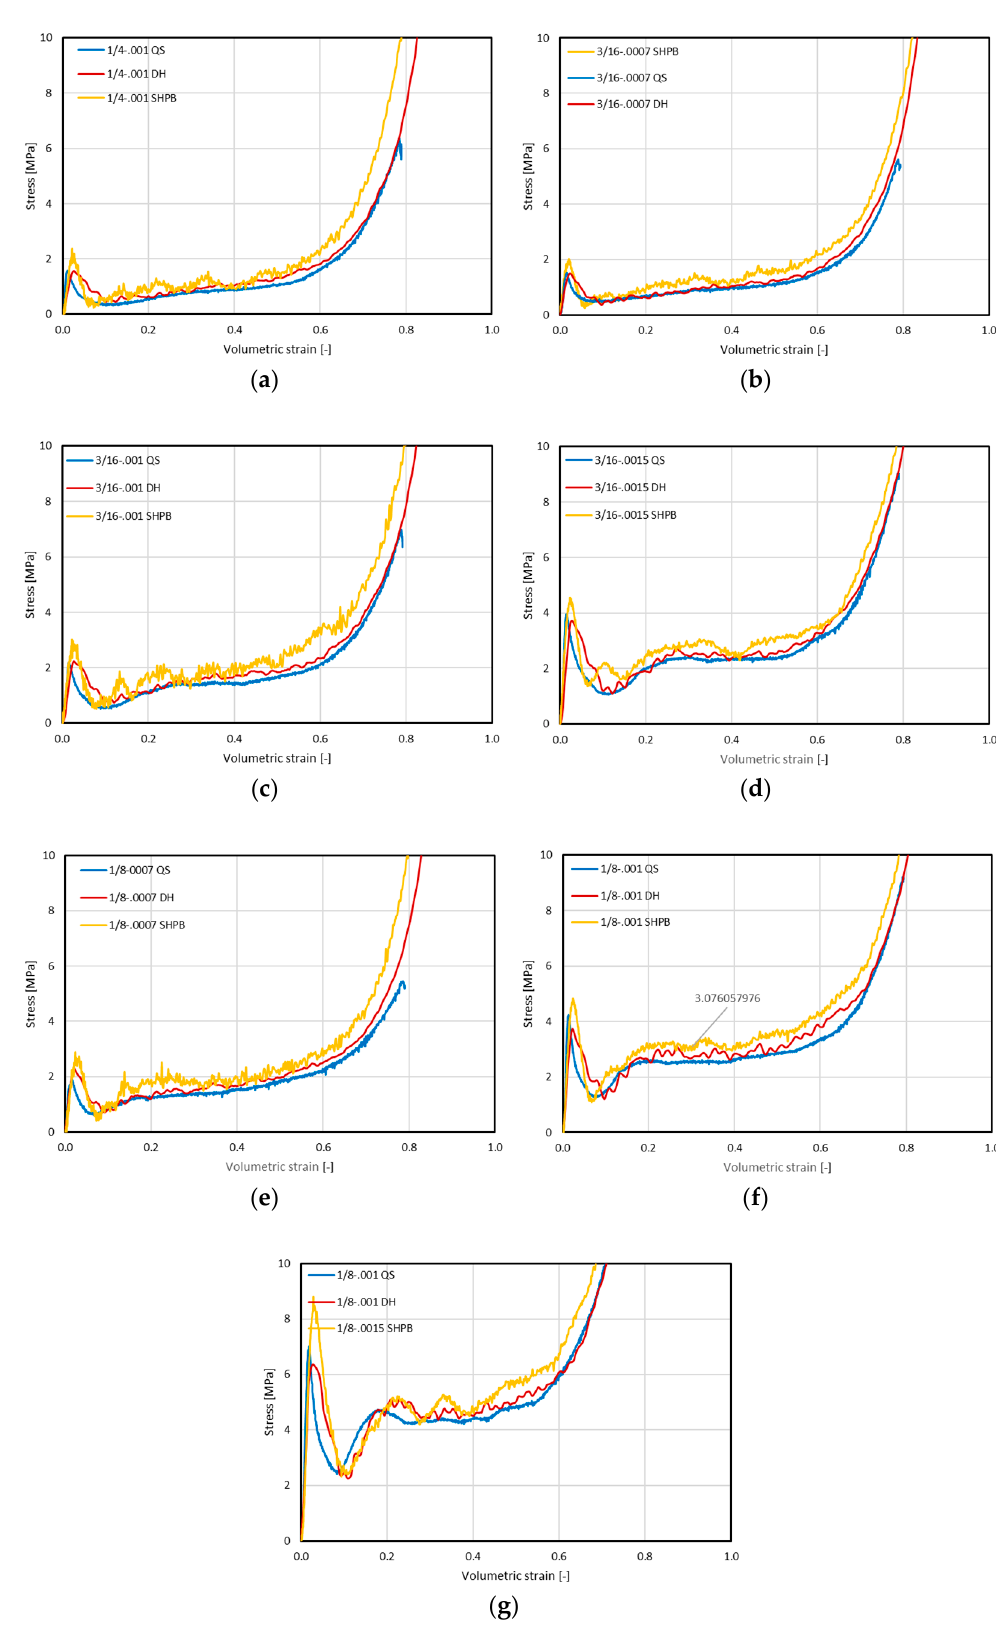
Figure 9. Set of stress vs. volumetric strain characteristics for samples series: ( a ) 1/4-5052-.001; ( b ) 3/16-5052-.0007; ( c ) 3/16-5052-.001; ( d ) 3/16-5052-.0015; ( e ) 1/8-5052-.0007; ( f ) 1/8-5052-.001; ( g ) 1/8-5052-.0015 for tested strain rates (QS—quasi-static, DH—drop hammer, SHPB—Split Hopkinson Pressure Bar).